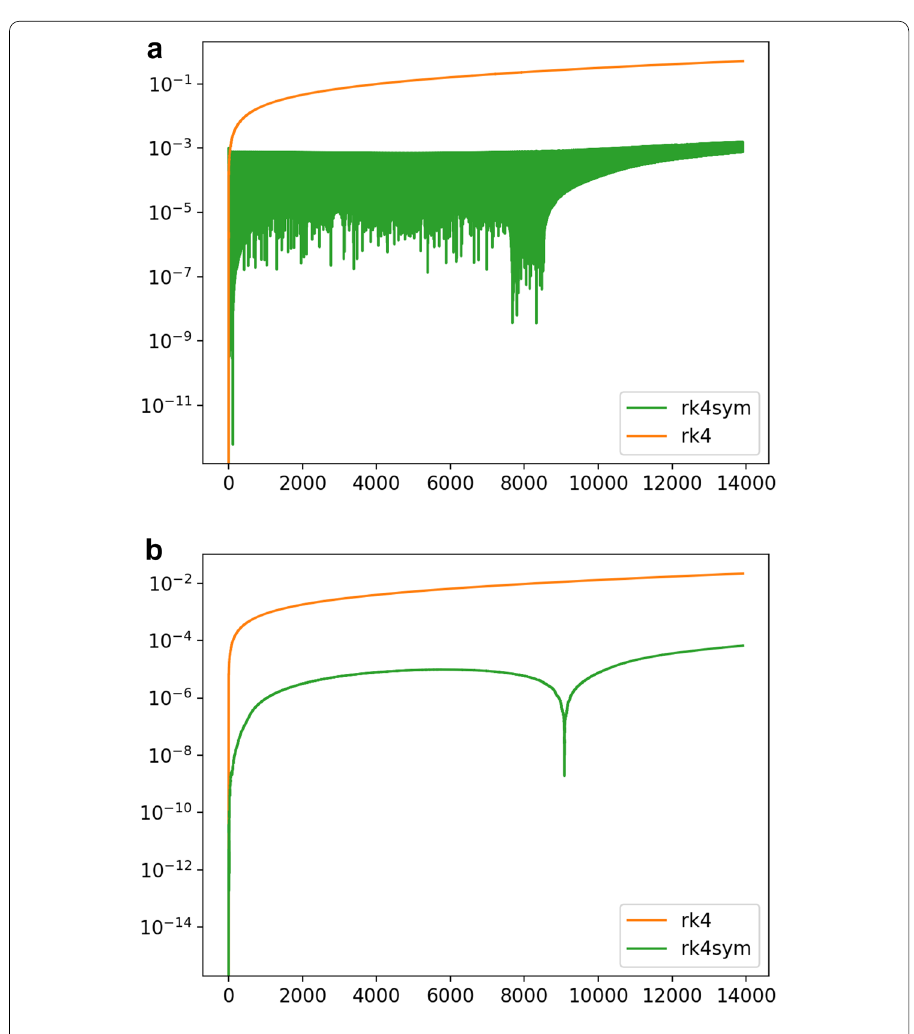
Fig. 8 Perturbed configuration. Error on the Hamiltonian ( a ) and on the angular momentum ( b )